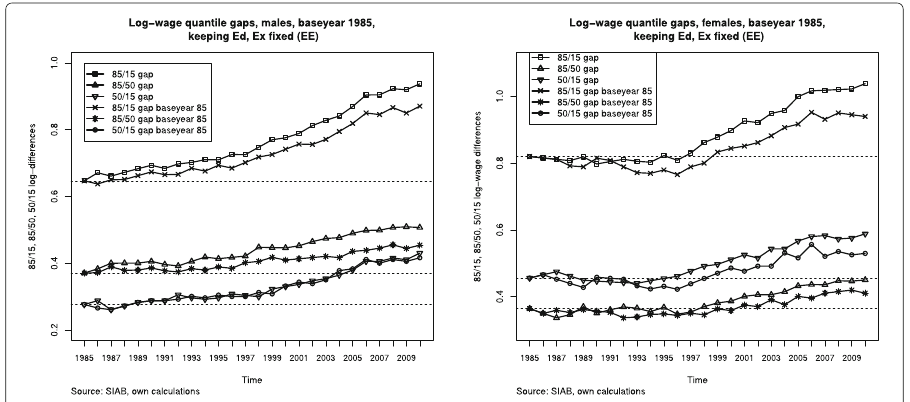
Fig. 11 Inequality development base year 1985, specification EE (Education, Experience)